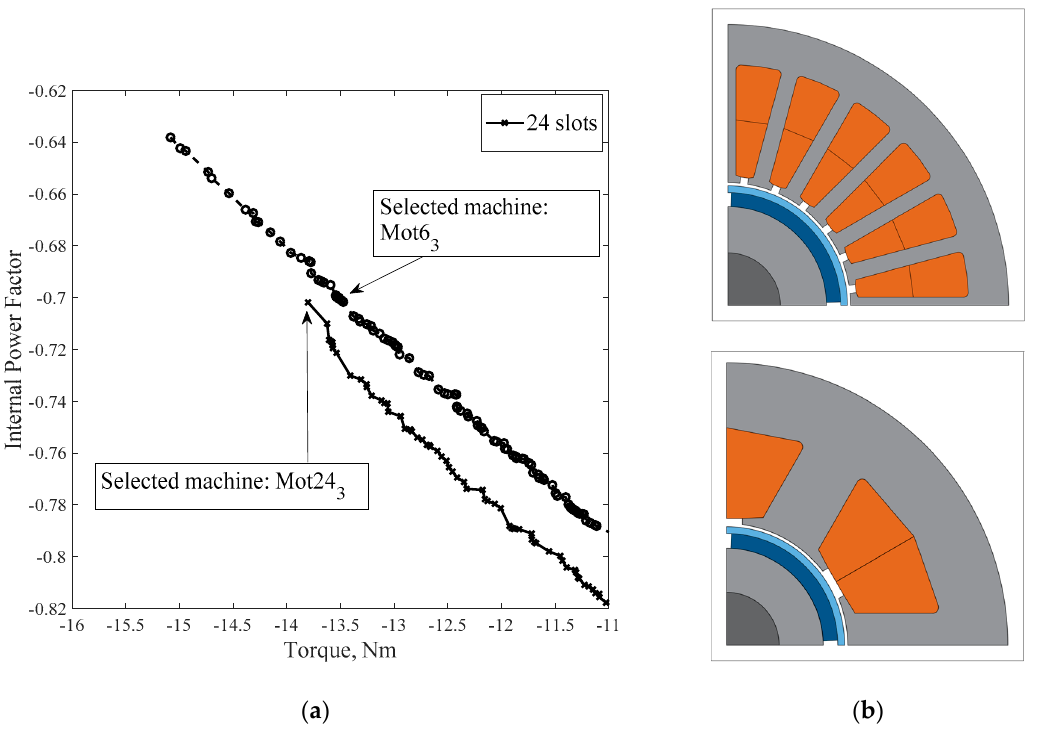
Figure 7. Pareto front of the T/IPF run ( a ) and selected 6-and 24-slot machines ( b ).